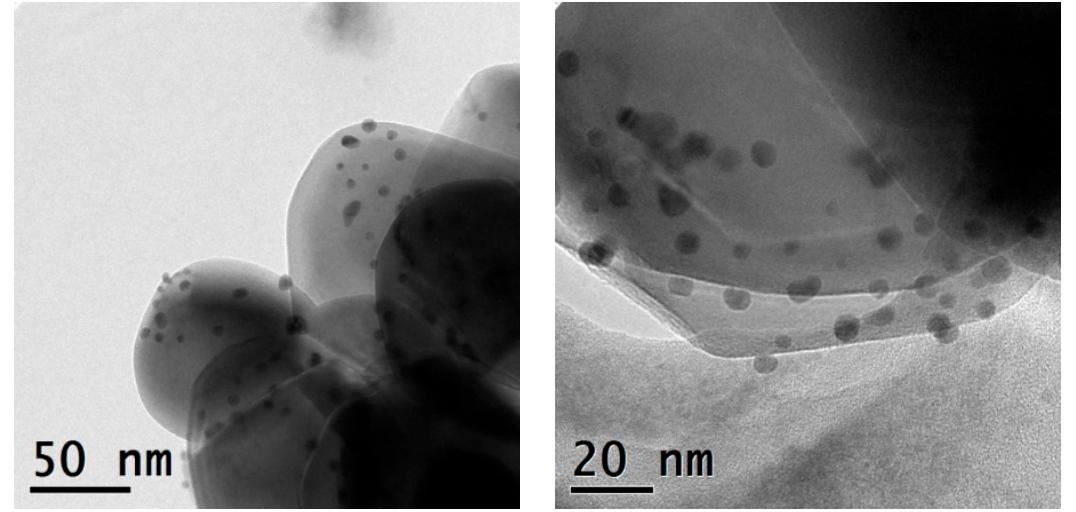
Figure 5. TEM micrographs recorded at a 71 K magnification and 145 K magnification of the 0.5%Au-TiO 2 catalyst.